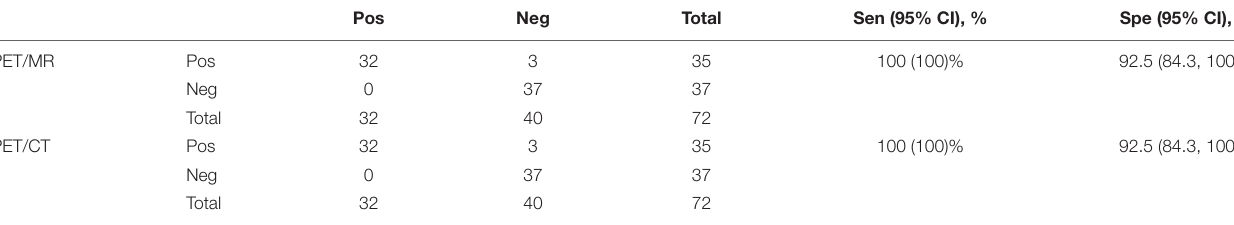
TABLE 4 | Diagnostic efficacy of 18 F-FDG PET/MR and 18 F-FDG PET/CT in ENKTL. Pos Neg Total Sen (95% CI), % Spe (95% CI), % PET/MR Pos 32 Neg Total 32 40 PET/CT Pos Total